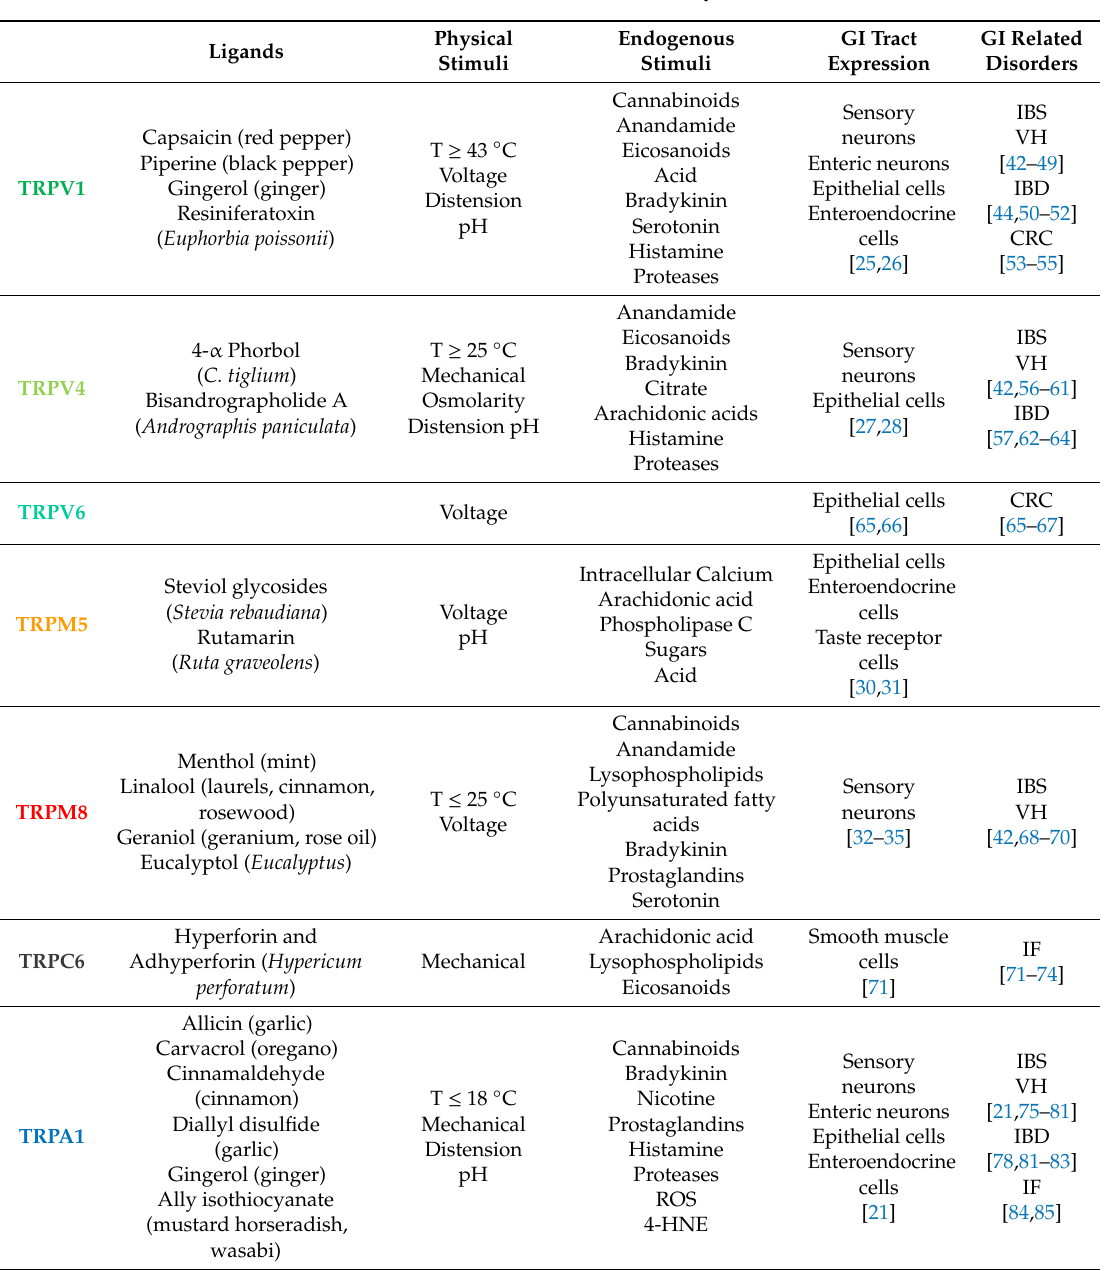
Table 1. TRP channels in the alimentary